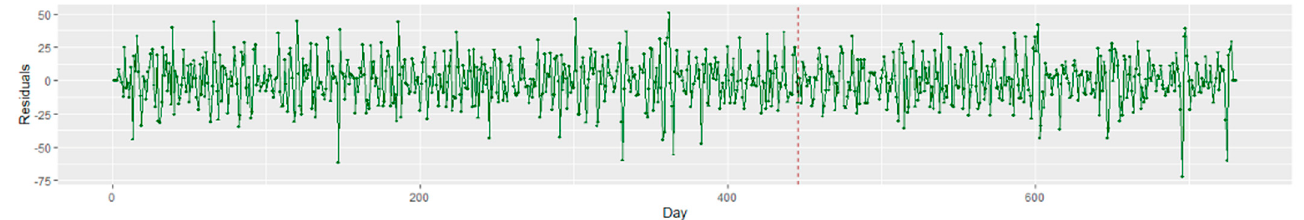
Figure 5. Time series plot of the stationary ED patient visits for 2019 to 2020. The red dash line depicts the start of the COVID lockdown in Michigan, USA.